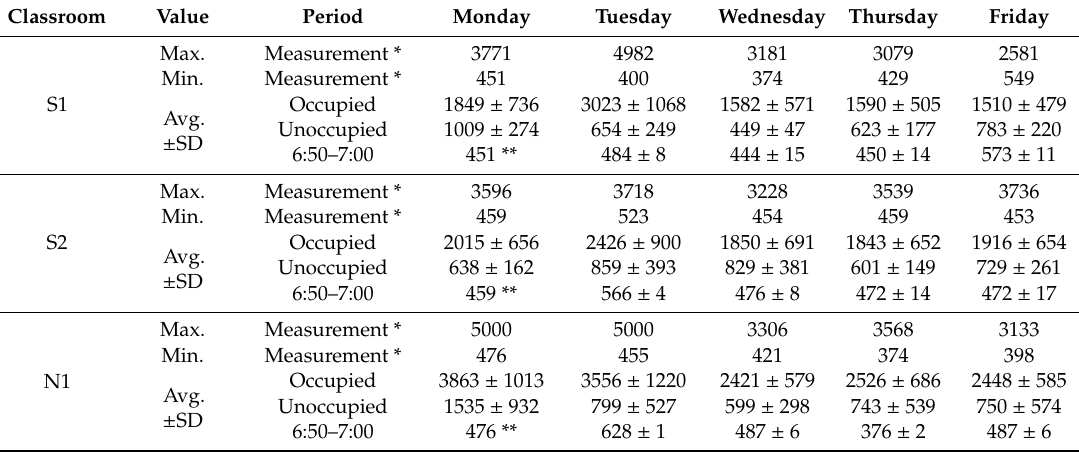
Table 5. Indoor CO 2 concentration (ppm) in the three study classrooms.